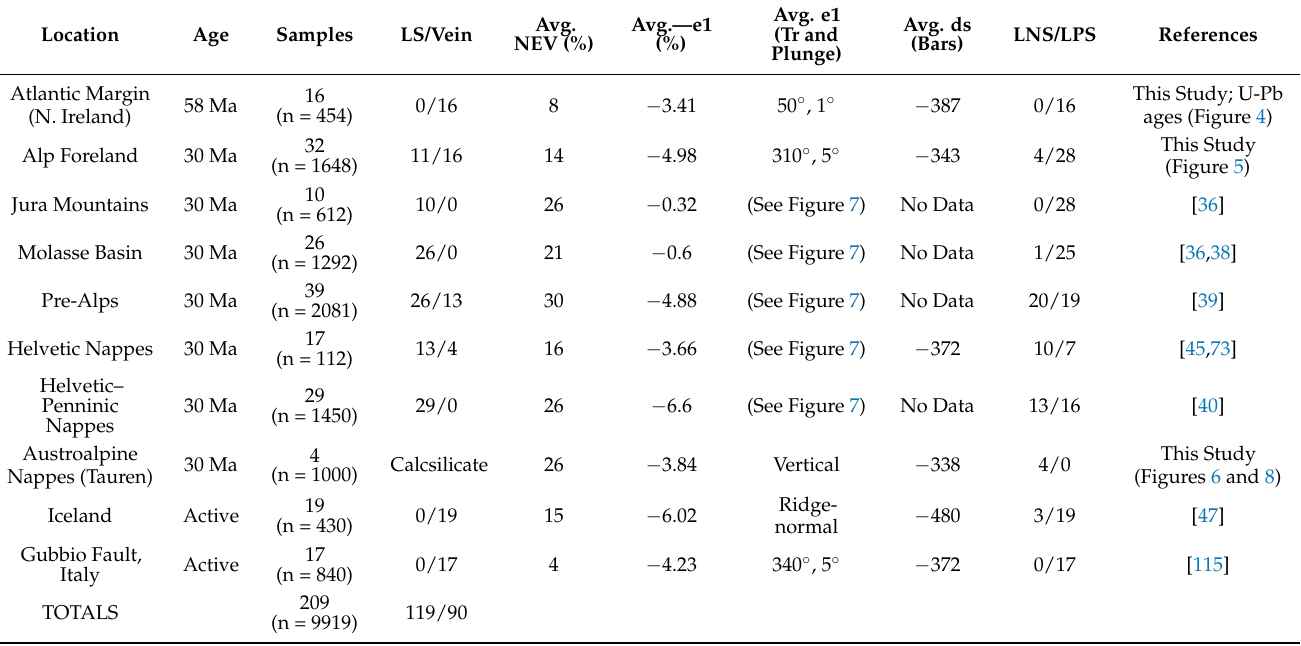
Table 1. Summary Calcite Twinning Strain